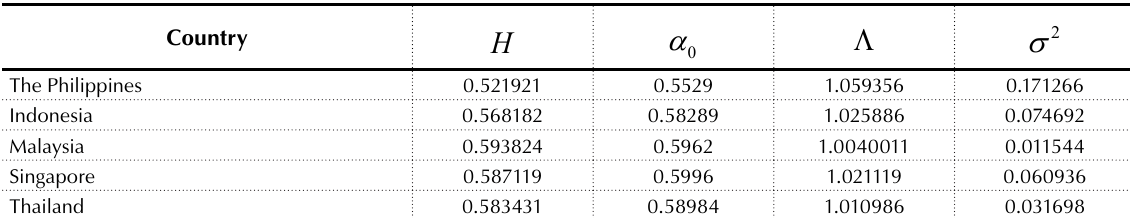
Table 7. Return series estimation results using multifractal model